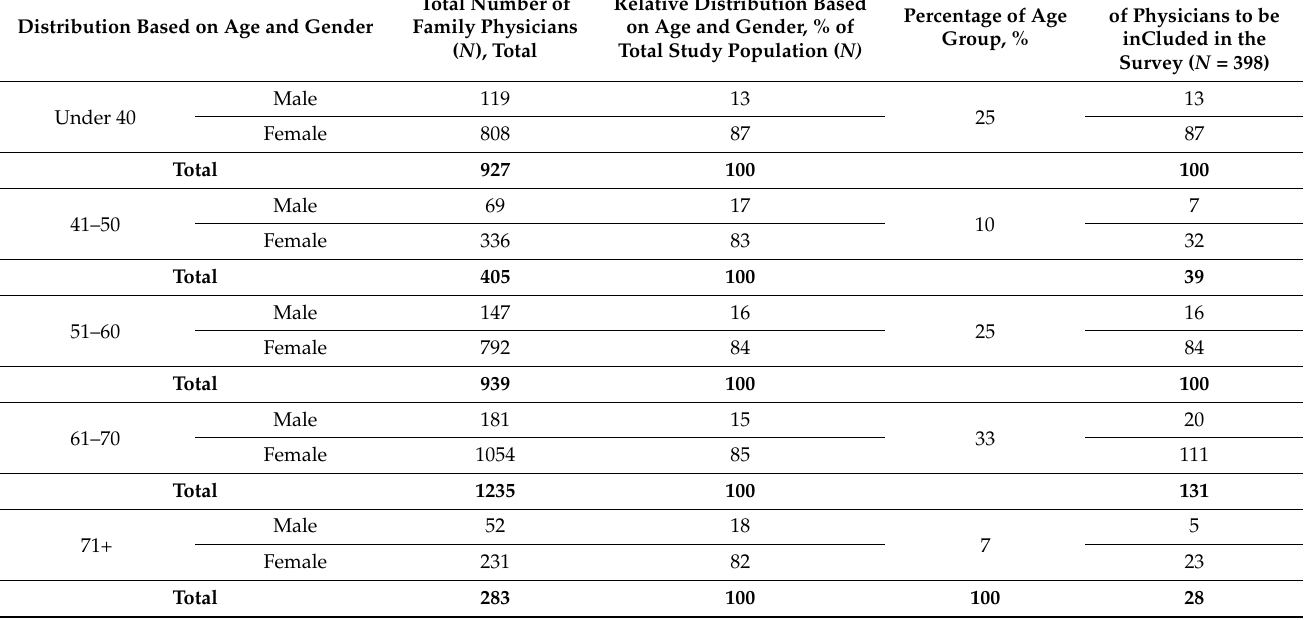
Table 2. The distribution of family physicians in the study population based on age and